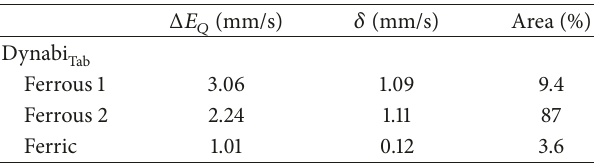
Table 2: The parameters of quadrupole splitting ( Δ𝐸 𝑄 ), isomer shifts ( 𝛿 ), and absorption area for Dynabi Tab .